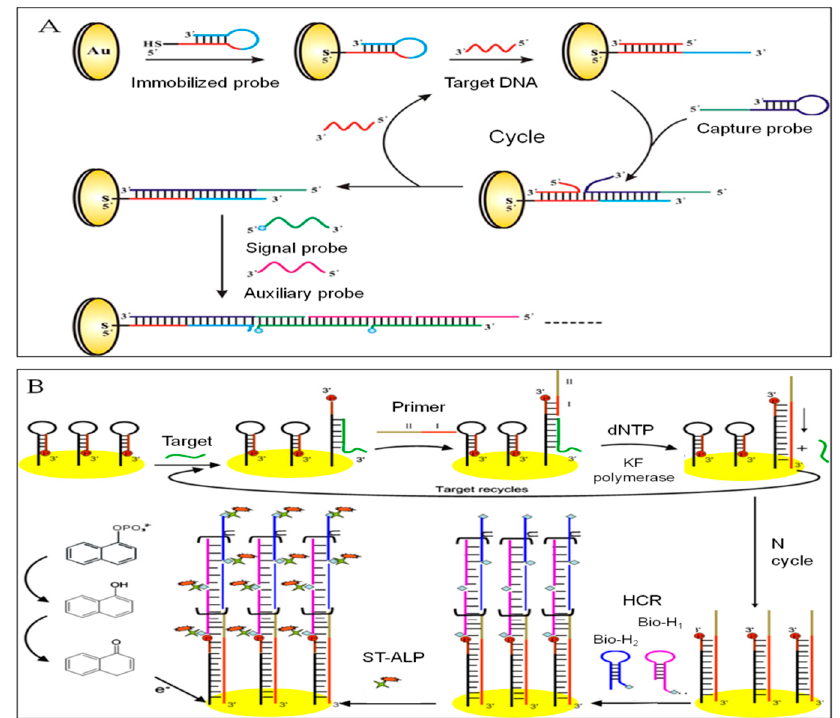
Figure 9. ( A ) An isothermal, enzyme-free and ultrasensitive design to detect DNA based on HCR and DNA catalyzed hairpin assembly (CHA) [155]. Copyright 2013. Reproduced with permission from Elsevier B.V. ( B ) An electrochemical DNA biosensor based on HCR and circular strand-displacement polymerase reaction (CSPR) [156]. Copyright 2013. Reproduced with permission from Elsevier B.V.